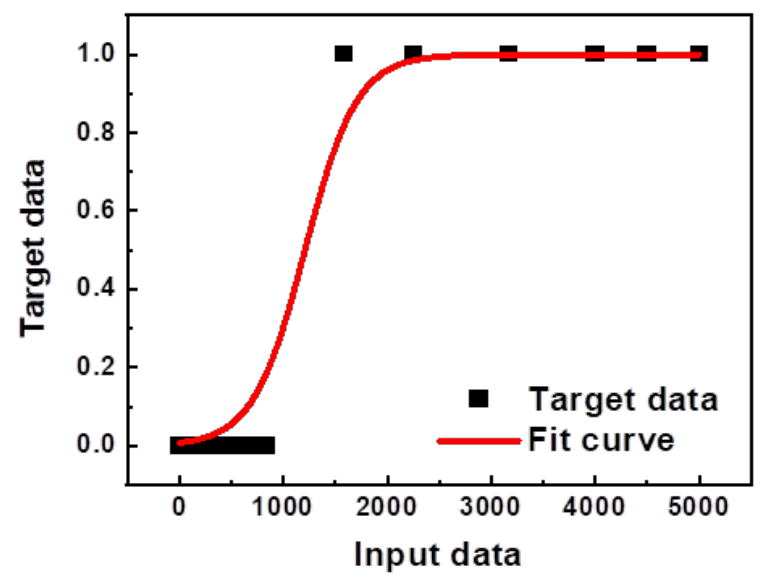
Figure 3. An example of a learned logistic regression curve.